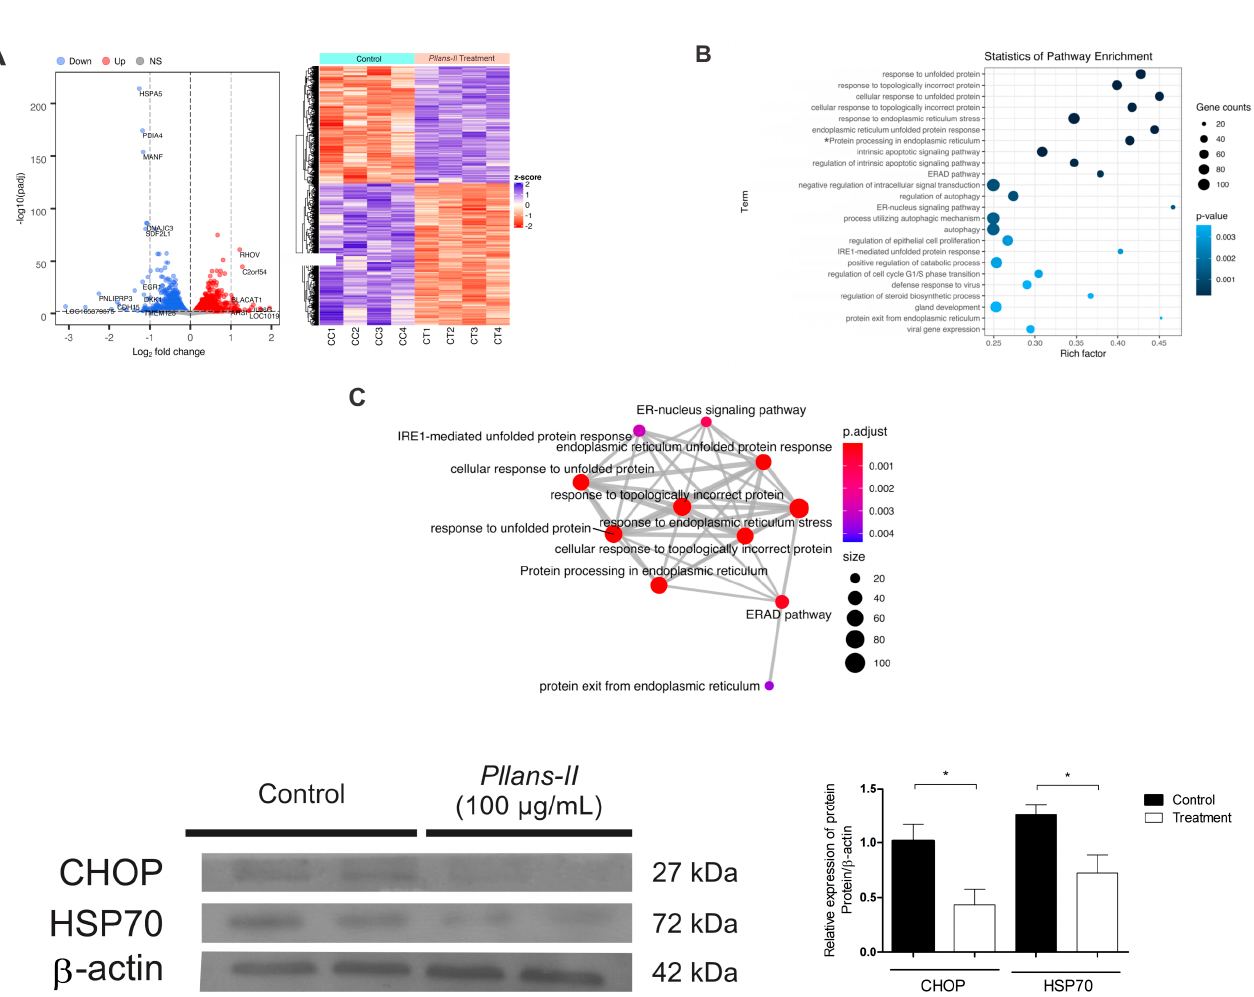
Figure 2. Pllans–II does not affect mitochondrial integrity but alters genes’ expression related to the response to endoplasmic reticulum stress. ( A ) Analysis of differentially expressed genes (DEG) from Ca Ski cells treated with Pllans–II and control. The red dots in the volcano plot represent genes with significantly higher expression in the treatment (up–regulated), while the blue dots represent genes significantly sub–expressed in the treatment group (down–regulated). The gray dots indicate genes that are not differentially expressed. The heat map shows changes in gene expression for each of the treatment and control samples. The red and blue colors represent, respectively, the increase and decrease in expression, while the white color indicates no change. ( B ) Pathway enrichment analysis. The term (Y–axis) represents the identification code and the pathway for the GO and KEGG databases. Asterisk (*) indicates the pathway found significant for KEGG. The enrichment factor (X–axis) represents the relationship between the number of differentially expressed genes and the total number of genes in a given pathway. The area of each colored circle is proportional to the number of genes involved in each pathway; the color indicates the p –adjusted value. ( C ) The most affected functional module of enriched terms map from Ca Ski cells treated with Pllans–II . The relation of the top–30 significantly richer terms (by p –adjusted values) are indicated by the thickness of the lines and represent the amount of DEG shared between each pair of terms. The size of each node indicates the gene count (number of genes enriched in each category) and the color represents the adjusted p –value. ( D ) Western blot analysis of HSP70, CHOP, and Actin protein after treatment with Pllans–II (100 µ g/mL). The densitometry of bands was quantified by ImageJ software and represented in a